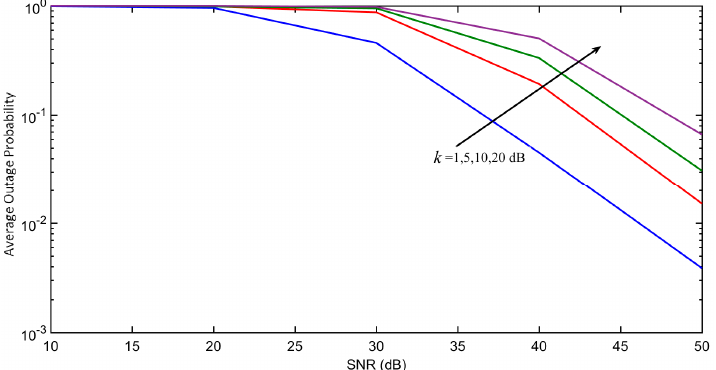
Figure 3. Impact of κ on average outage probability. The bottom first line (blue) is for k = 1 dB, second line (red) is for k = 5 dB, third line (green) is for k = 10 dB, and fourth line (purple) is for k = 20 dB, ordered by the direction of the arrow.